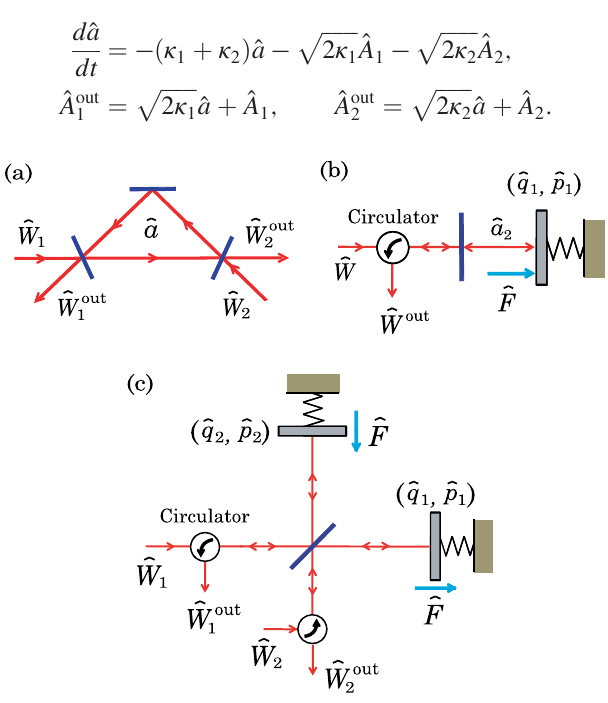
FIG. 3. Examples of open linear quantum systems. (a) Optical cavity with two input and output fields, (b) mechanical oscillator coupled to an optical cavity, and (c) Michelson ’ s interferometer with two identical